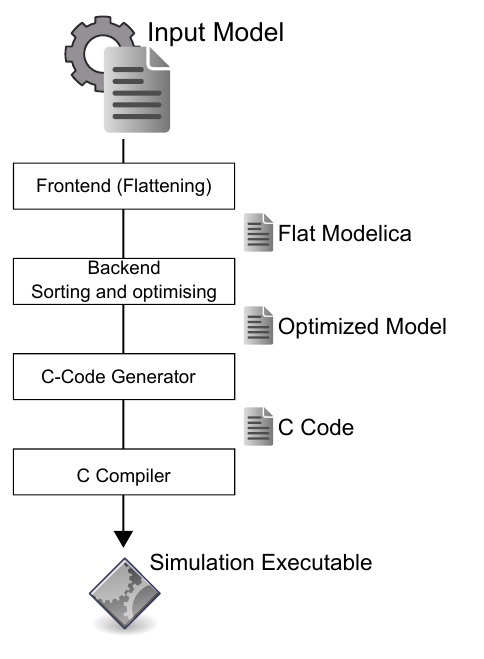
Figure 1: The typical stages of translating and execut- ing a Modelica